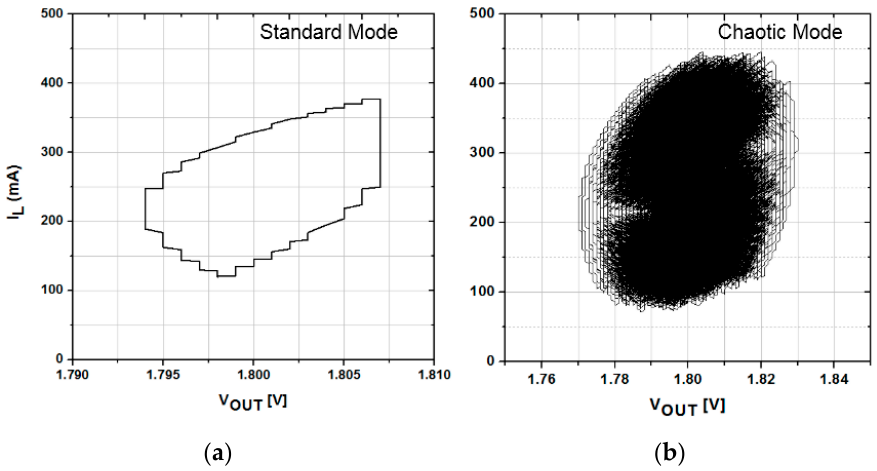
Figure 9. Operation mode of buck converter under phase-portrait view between two internal states (output voltage and inductor current): ( a ) Standard mode. ( b ) Chaotic mode.